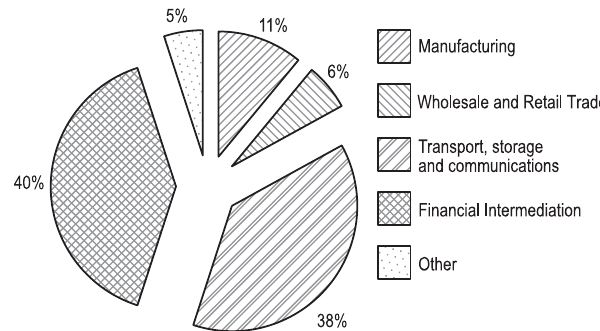
Fig. 3 . Sectoral Distribution of FDI in Turkey. Other: Agriculture, construction, electricity, gas and water supply, health and social work, hotels and restaurants, real